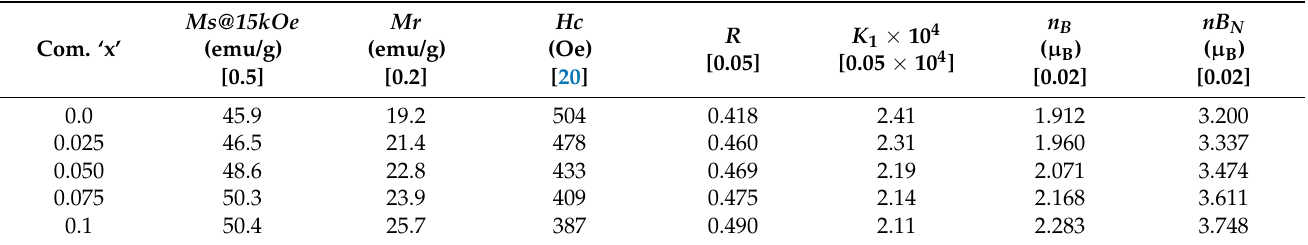
Table 6. Magnetic properties of CoCr 0.5 Dy x Fe 1.5 − x O 4 . Figures in the square bracket refers to the estimated